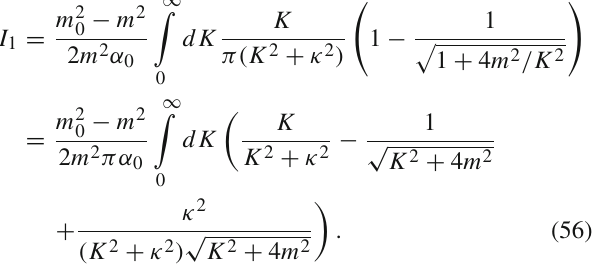
Fig. 1 The contour C in the integrals (45) and (55)